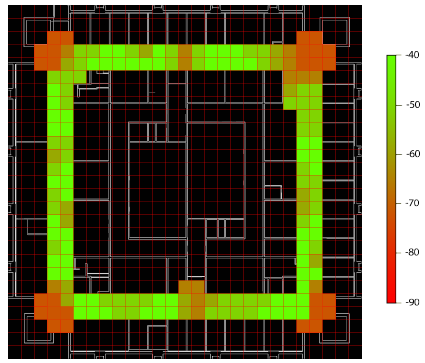
Figure 6. Mean RSSI map of fingerprints collected manually